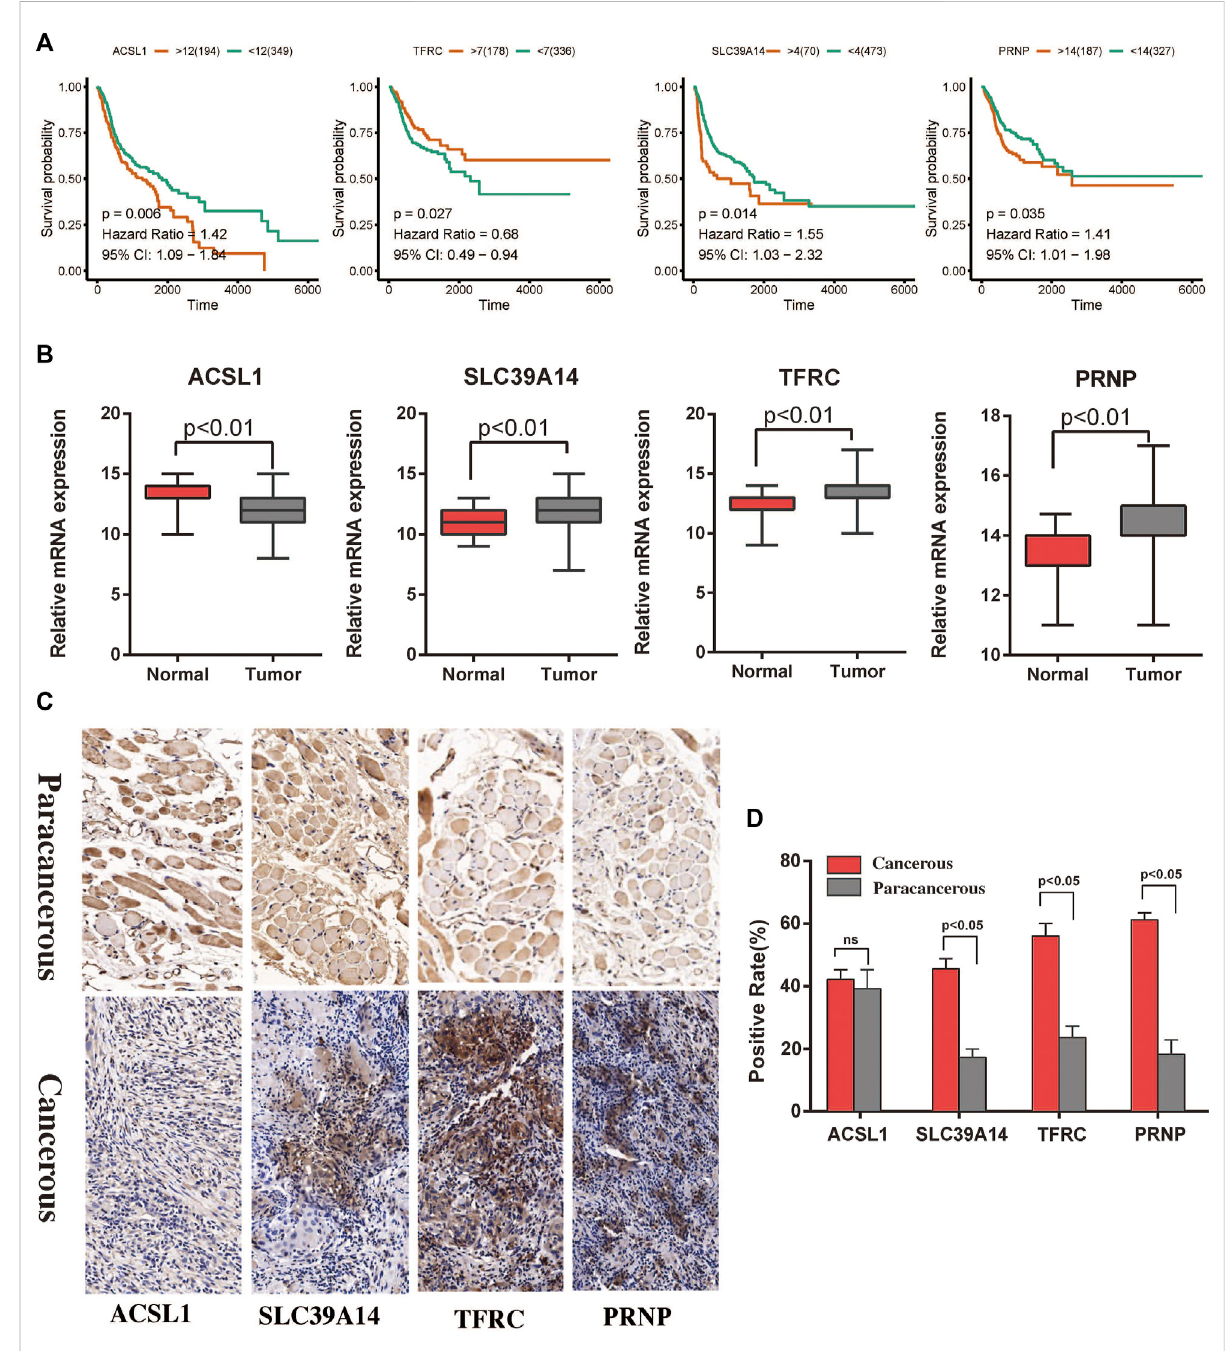
FIGURE 6 Survival analysis and immunohistochemistry to detect differential expression analysis of the hub genes. (A) Associations of the ACSL1 , SLC39A14 , TFRC , and PRNP genes with the survival of patients with HNSCC in TCGA. (B) Differential expression of the ACSL1 , SLC39A14 , TFRC , and PRNP genes between cancerous and paracancerous tissues in TCGA. (C,D) Expression of ferroptosis related proteins between the cancerous and paracancerous tissues